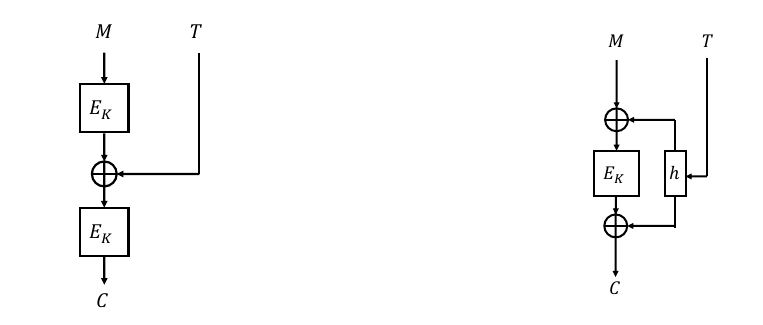
Figure 2: The LRW constructions. LRW1 is depicted on the left, and LRW2 is depicted on the